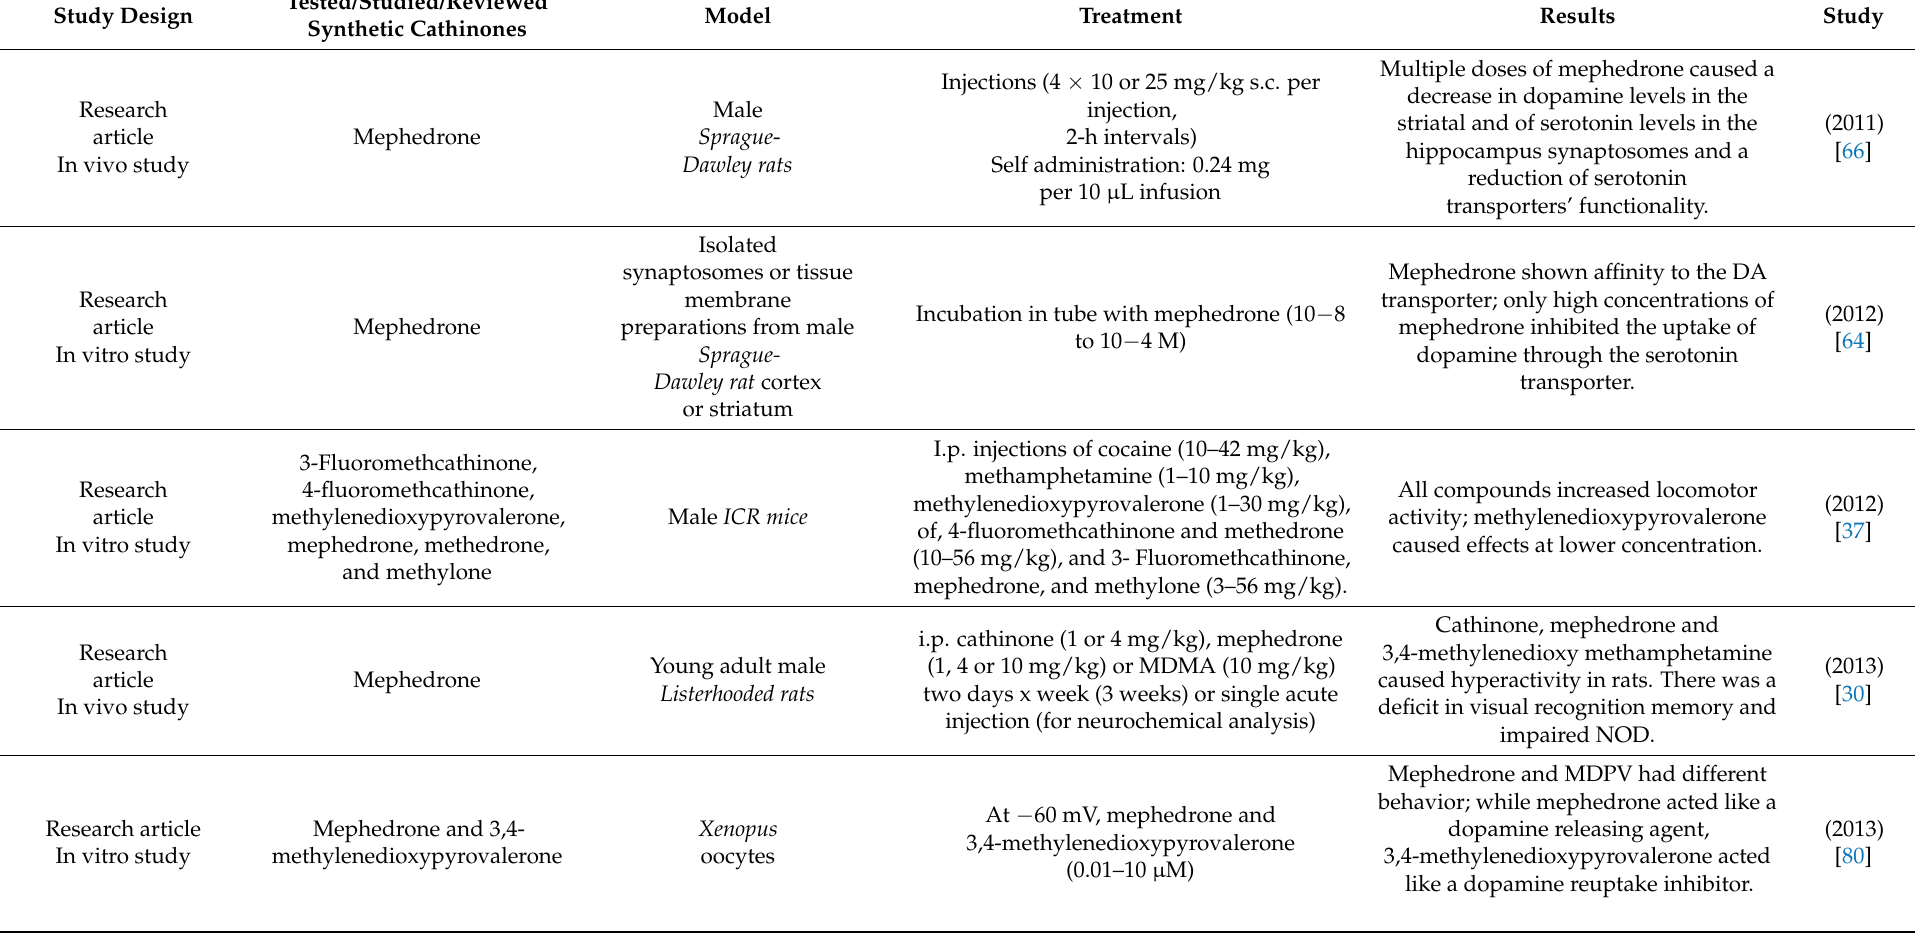
Table 1. Characteristics of eligible animal studies in vivo and in